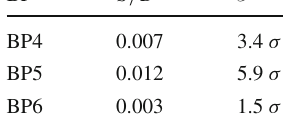
signal significance for the benchmark points at 13 TeV with L = 3000 fb − 1 in the b ¯ b + / E T channel, after using